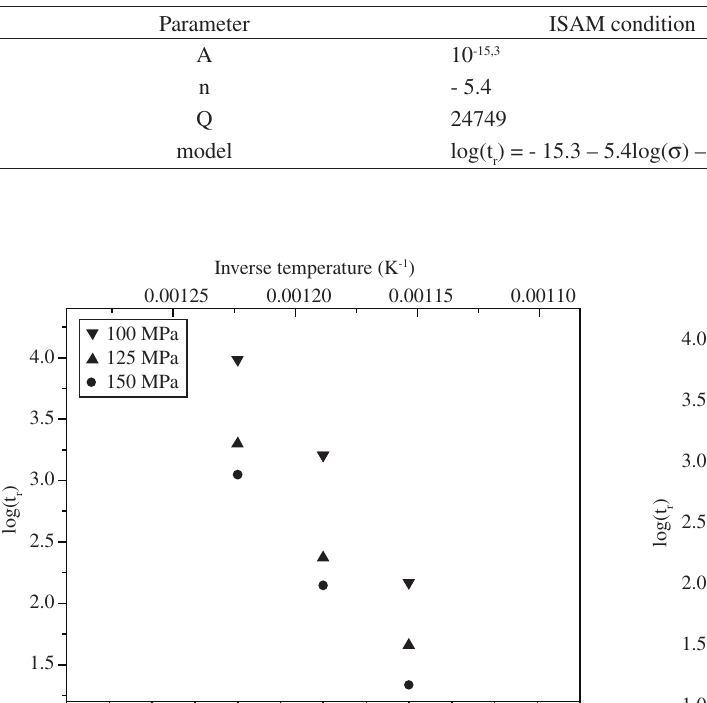
Table 2. Value of model parameters (Equation 1) for each condition.